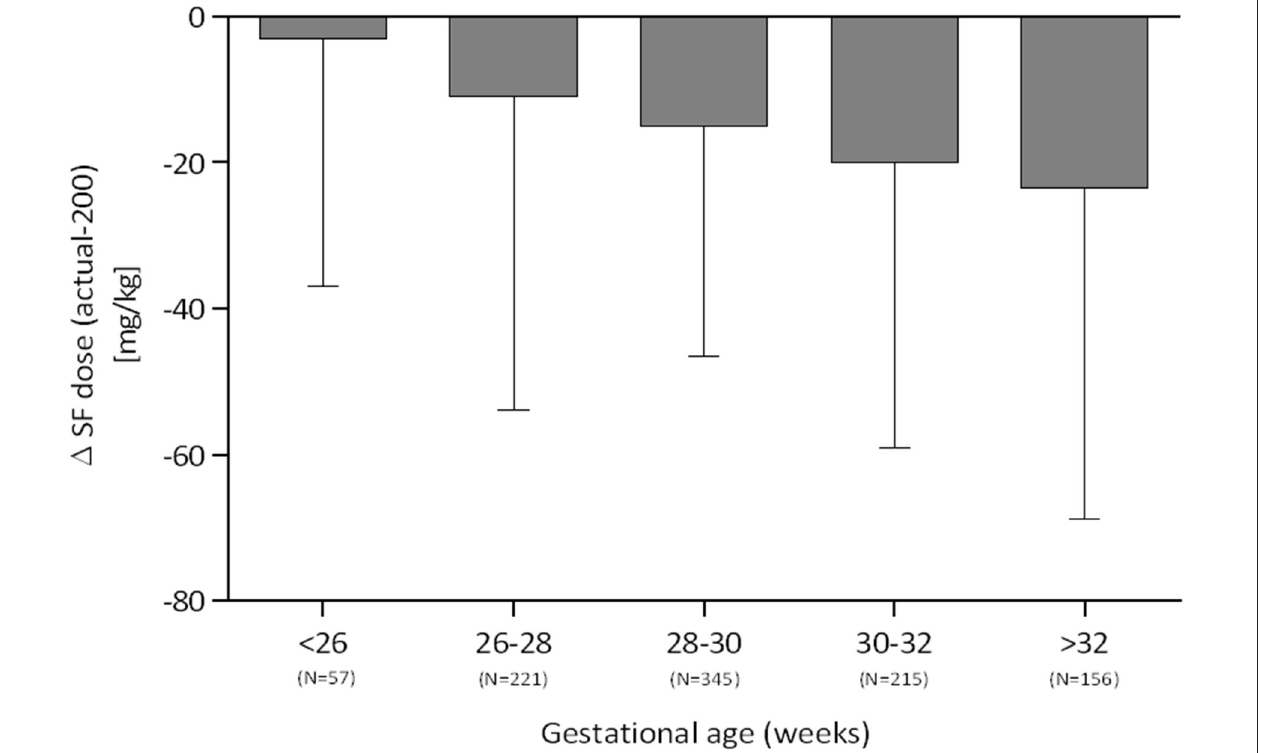
caused the dose of 200 mg/kg to often not be reached. In daily practice, the actual dose is frequently rounded down, particularly in more mature newborns with higher birth weight and